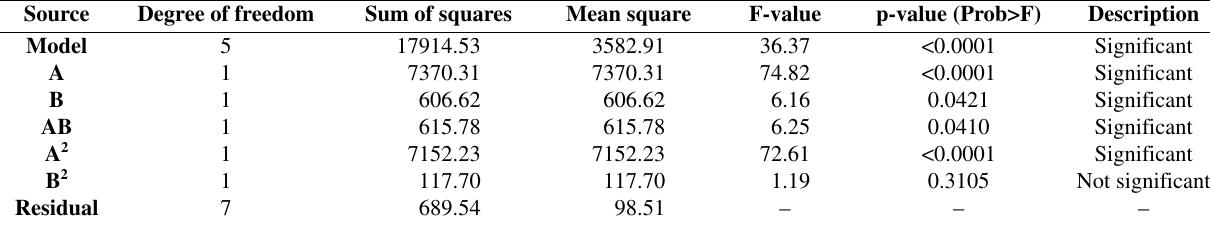
Table 8. Regression analysis (ANOVA) of RSM of AY 17 Source